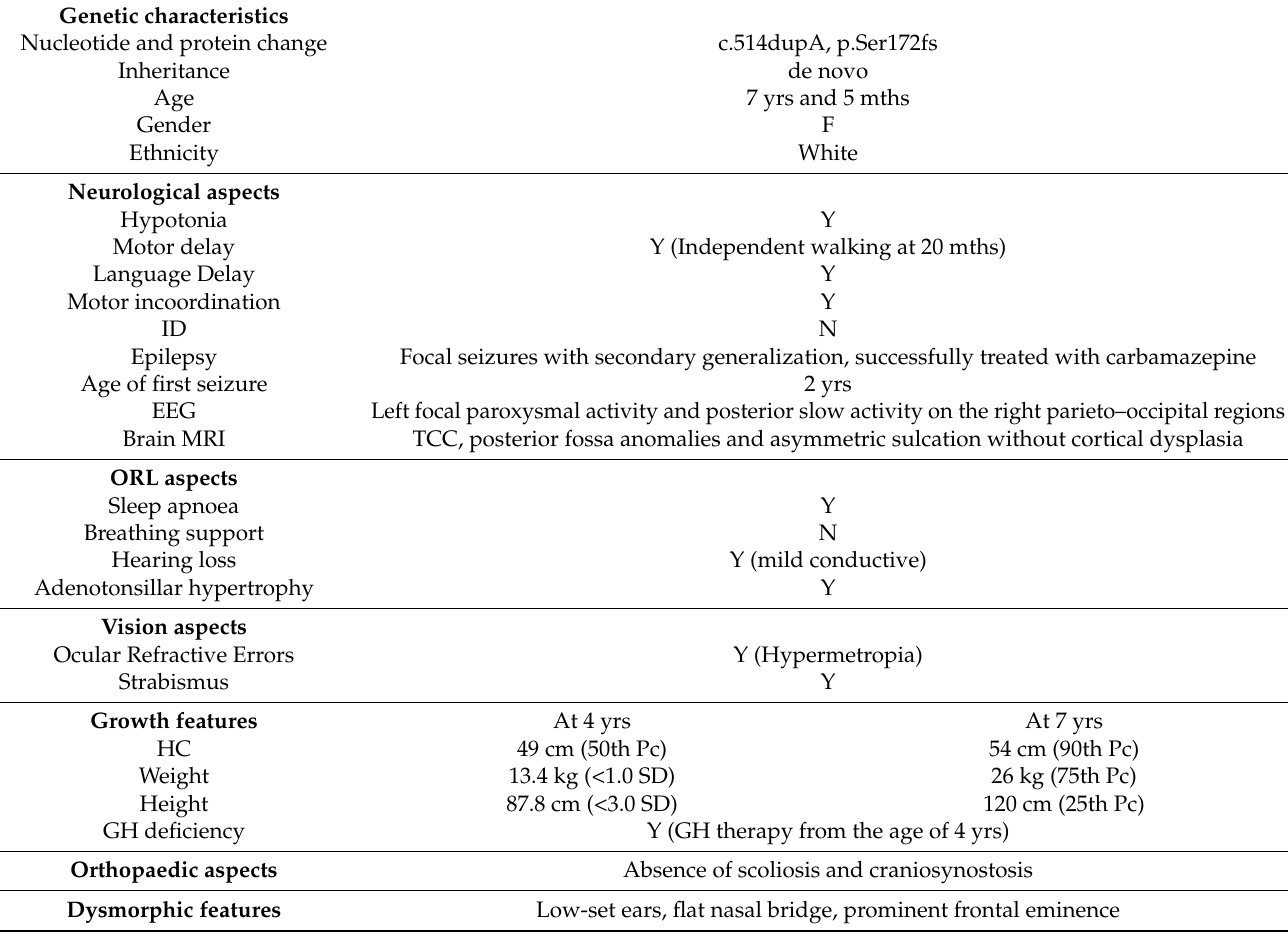
Table 2. Neuropsychiatric profile between the ages of 3 and 4 years old was characterized by autism spectrum disorder, attention deficit, motor dyspraxia, and disharmonic